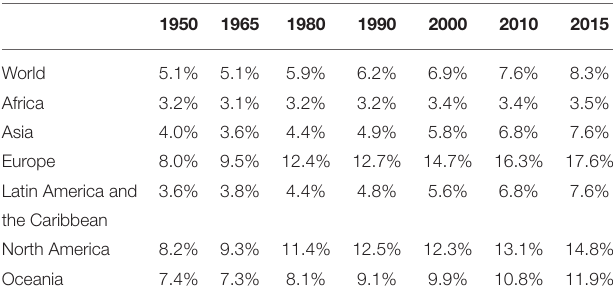
TABLE 1 | Evolution of the weight of people over 64 years old over the total population by world regions (%,